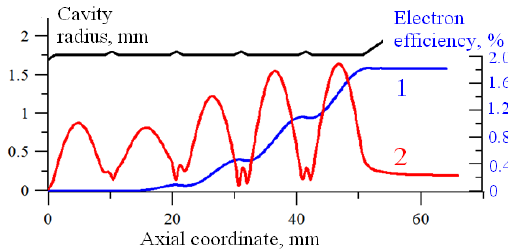
Fig. 2. Large-orbit fourth-harmonic gyrotron: cavity shape, the calculated electron efficiency versus the axial coordi- nate, and the spatial rf-wave structure of the operating mode corresponding to the 5 th axial